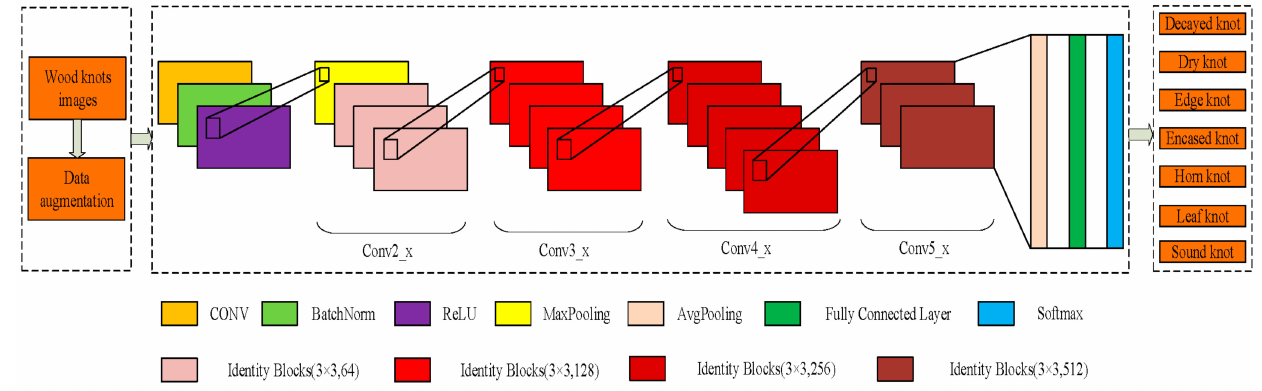
Figure 4. Structure and flowchart of wood knots recognition on the Pytorch